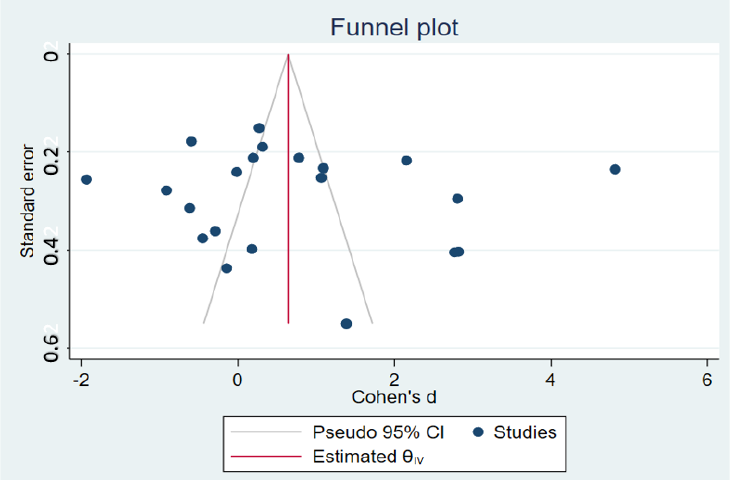
Figure 9. The funnel plot of each study depicts the distribution of the SMD of IL ‐ 10 levels between severe and non ‐ severe malaria. The funnel plots show the asymmetric distribution of the SMDs of IL ‐ 10 levels and their standard error (se).